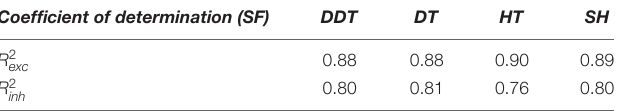
TABLE 3 | Coefficients of determination of the excitatory ( R 2 exc ) and inhibitory ) power-law models used to fit SF network degree distribution. ( R 2 inh